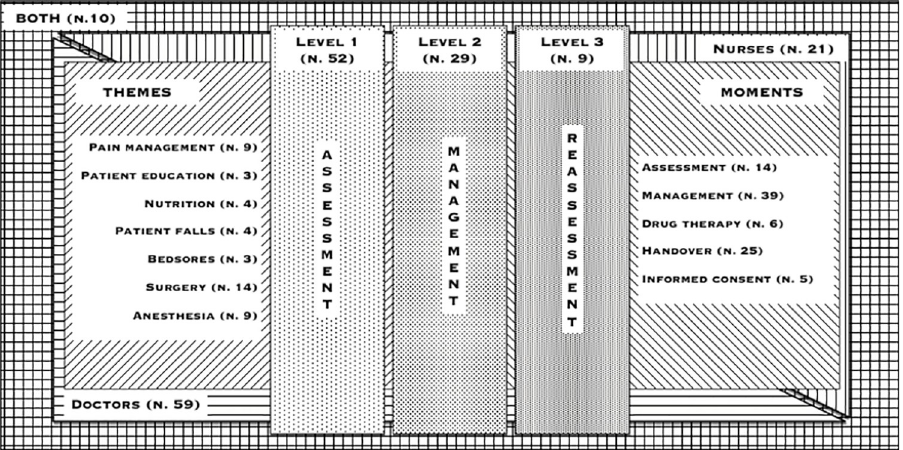
Fig 1. Model of the peer-review tool. The total number of items identified during the seven years experience reached a total of 92 items. The items belong to different healthcare workers profiles: doctors (n. 59 items), nurses (n. 21), both of them (n. 10) and therapist (n. 2 –not shown). The items, moreover, explore 7 themes (n. 46), 5 moments (n. 89) and 3 levels (n.